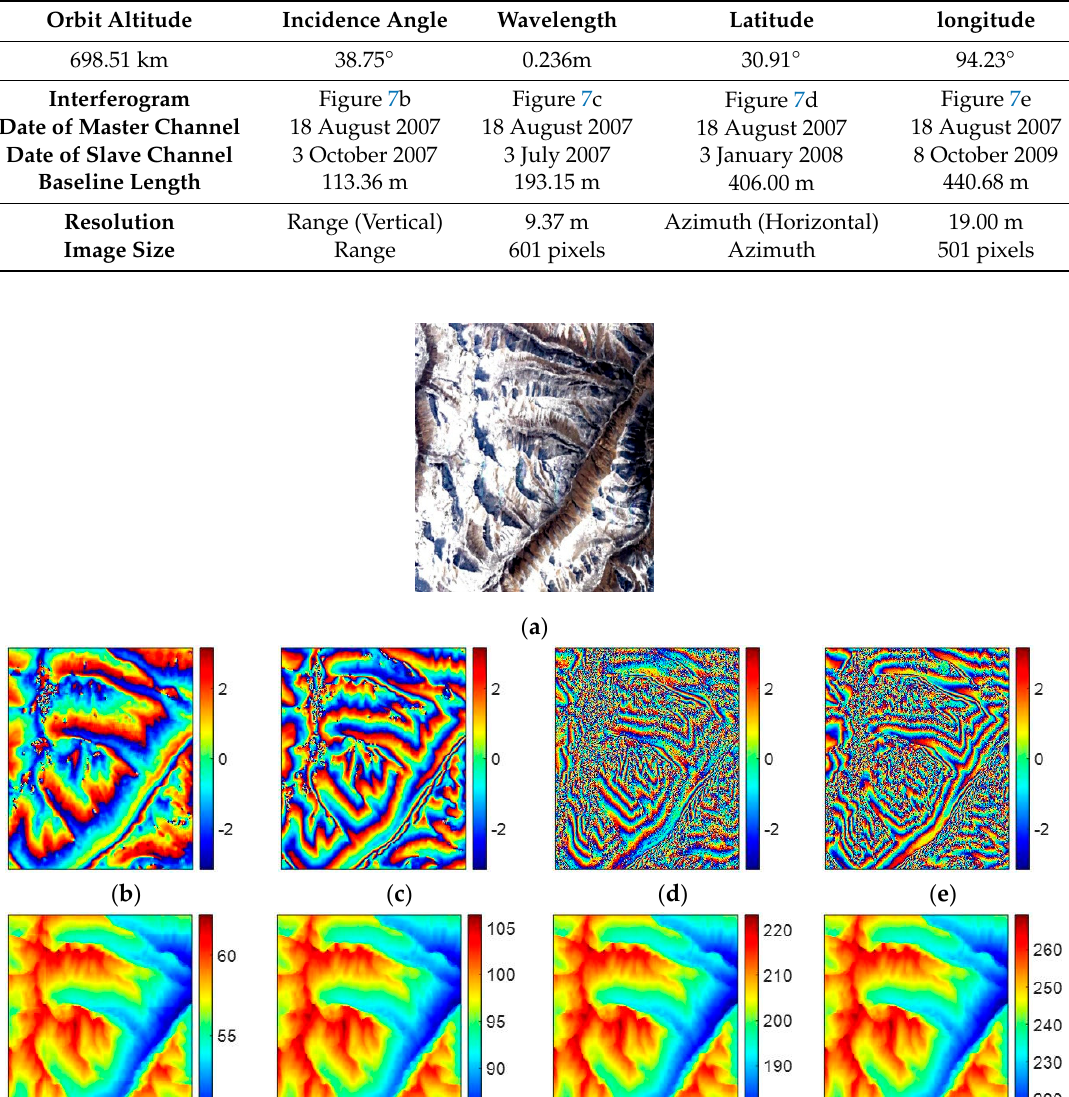
Table 6. Major interferometric parameters of real MB dataset of ALOS